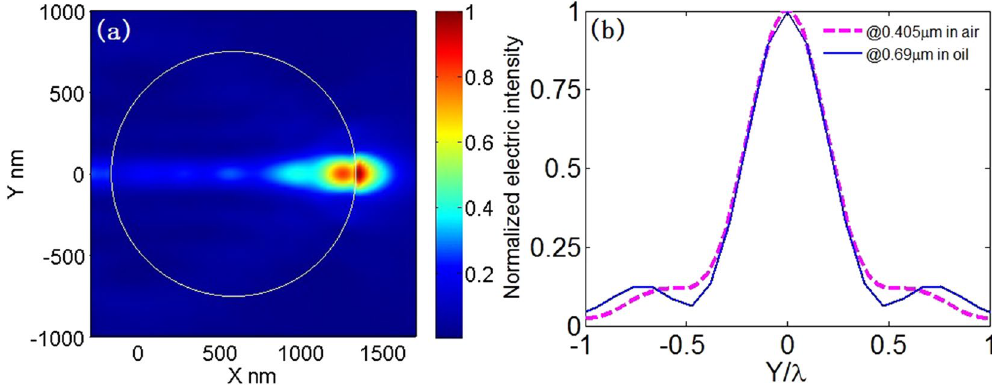
Figure 8. ( a ) Electric intensity distribution around the microsphere immerged in water. The system parameters are: λ